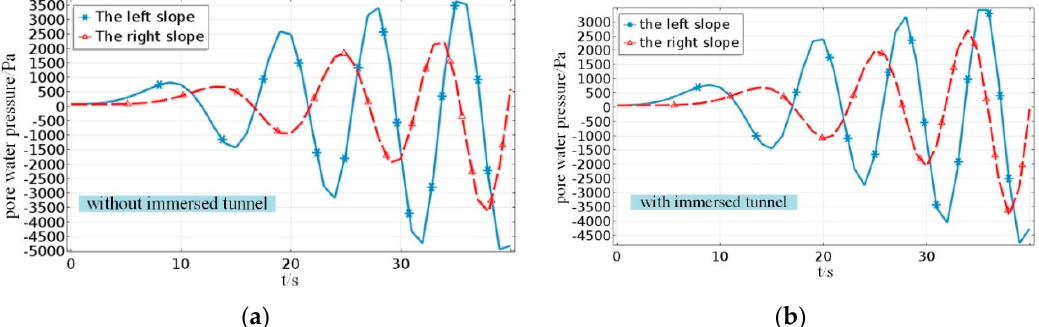
Figure 8. The pore pressure at two asymmetric points on the two-side slopes: ( a ) without immersed tunnel and ( b ) with immersed tunnel.